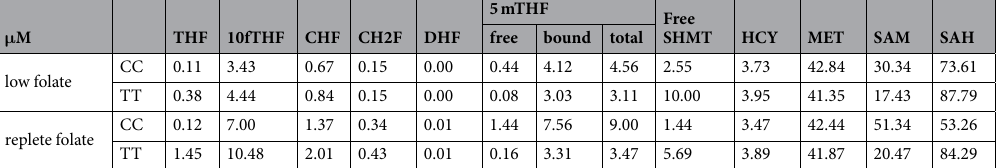
Table 7. Concentrations of model variables (in µ M) for replete (18 µ M) and low (9 µ M) levels of total folate and for the CC and TT case of the C667T MTHFR